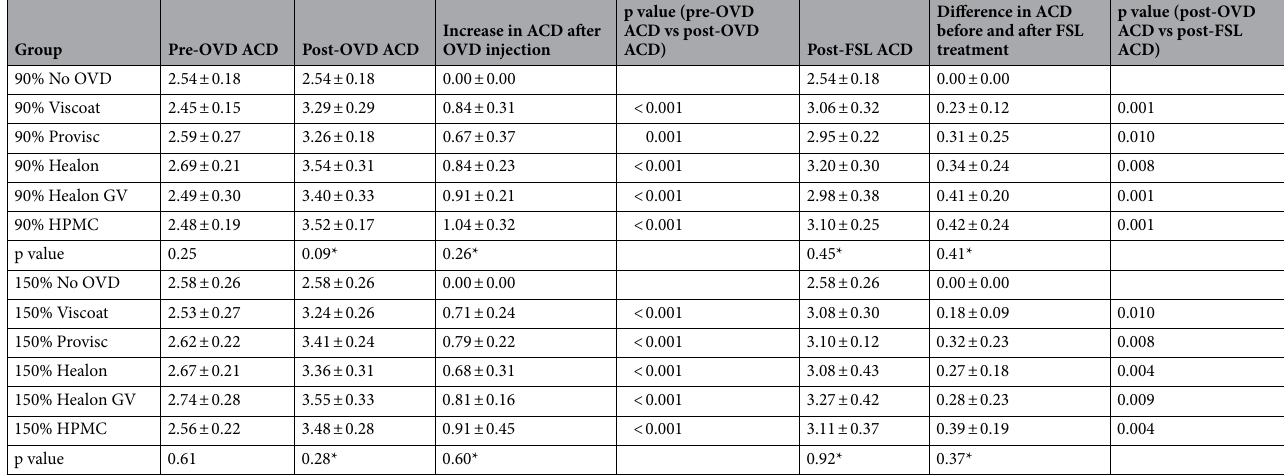
Table 1. Comparison of anterior chamber depth (ACD) in different sub-groups with 90% and 150% energy settings. p values comparing the groups in the presence of different types of OVD.